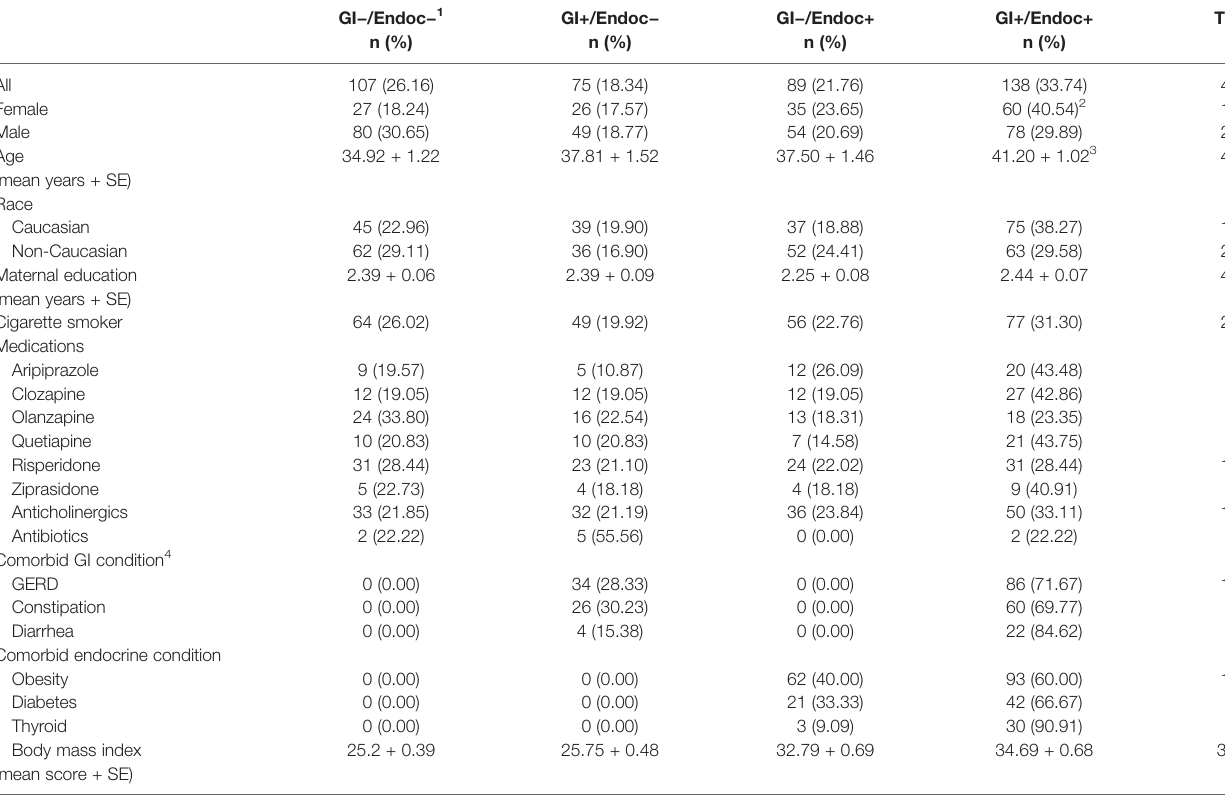
TABLE 2 | Characteristics of the sample by GI and endocrine comorbidity